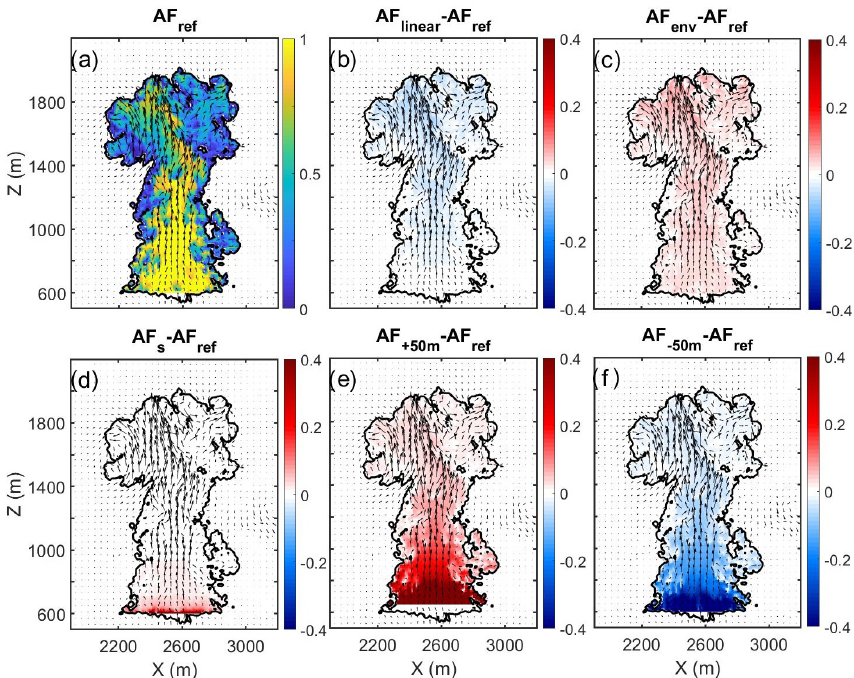
Figure 3. Vertical cross sections of the differences between the various assumptions used when calculating AF. (a) The method of calculating AF that is used as the reference (AF ref ; as presented in Fig. 1e). (b) AF ref subtracted from an AF that is linear from cloud base (AF linear ). (c) AF ref subtracted from AF env , calculated using sounding (environmental) profiles. (d) AF ref subtracted from AF s , which considers the supersaturation term (Eq. 5). (e) The error in AF caused by overestimating cloud base by + 50m. (f) Same as (e) with a − 50m error.